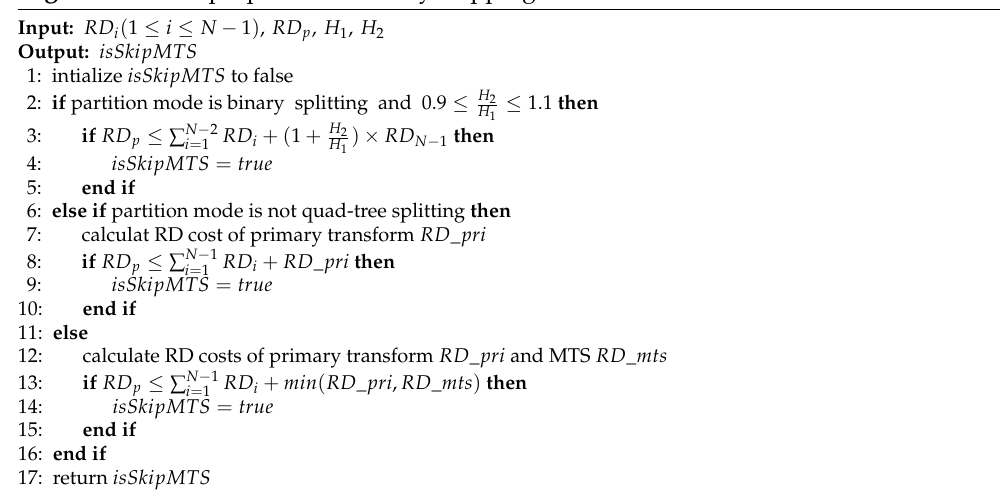
Algorithm 1 The proposed MTS early skipping method